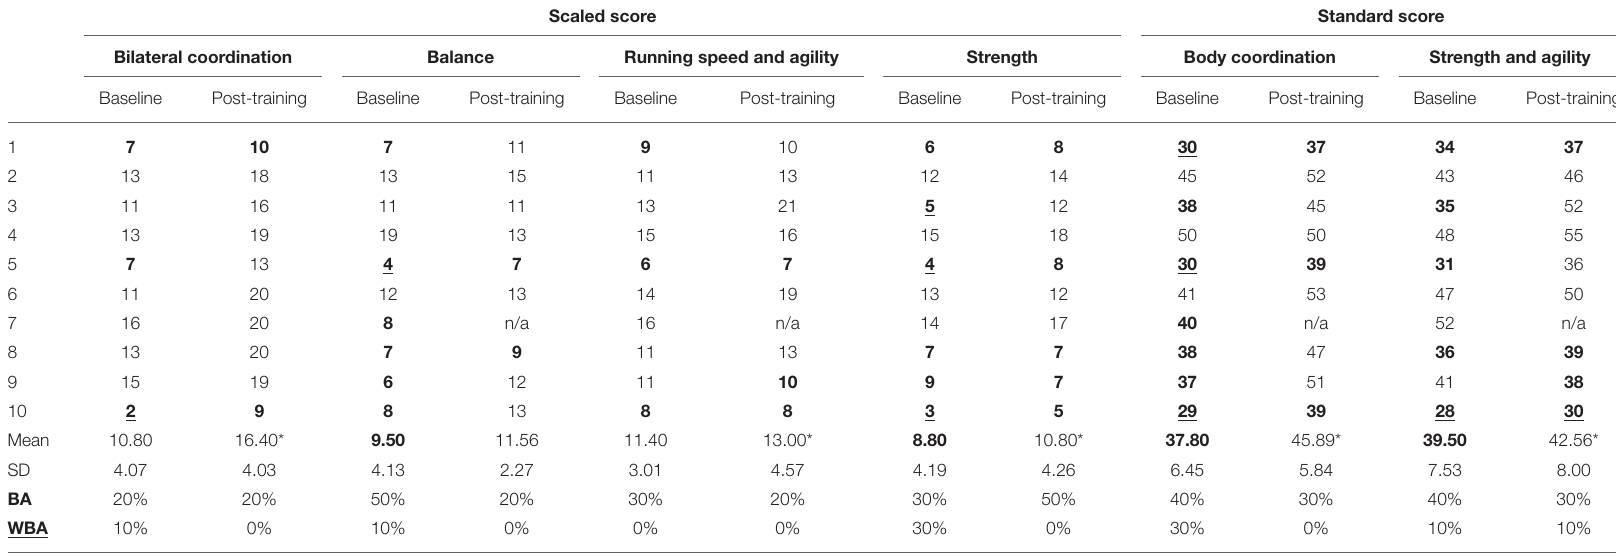
Bold indicates score below average (BA); bold and underlined indicates score well-below average (WBA). n/a indicates not applicable. * Indicates P < 0.05 for Wilcoxon signed-rank test between baseline and